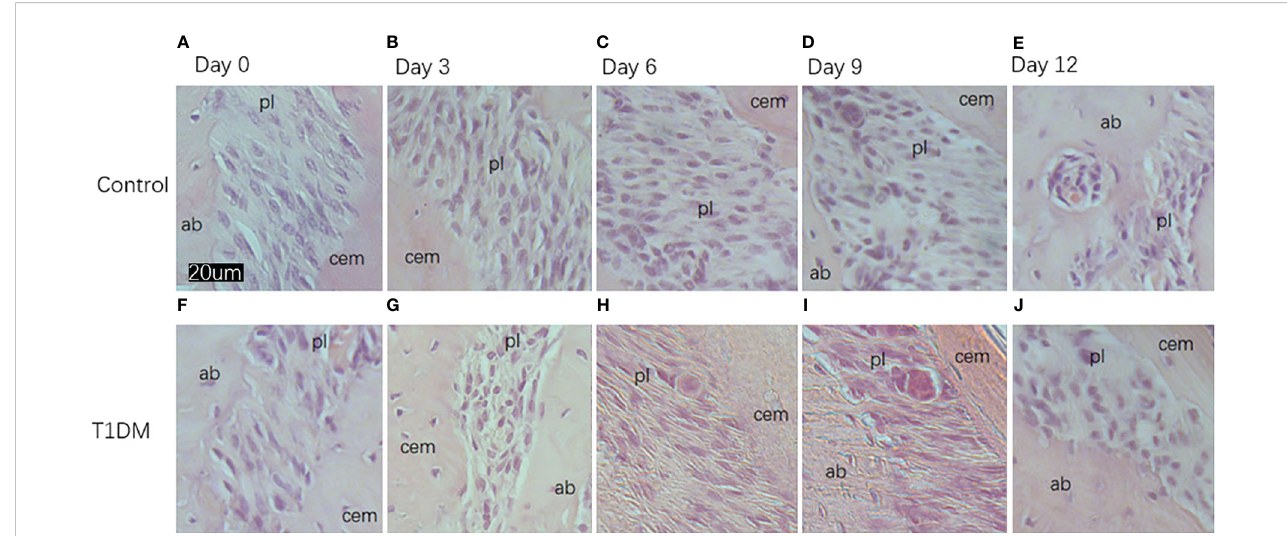
FIGURE 4 Histological appearance (HE staining)of the periodontium of mandibular molars in both groups on days 0, 3, 6, 9, and 12 of the experiment. (A – E) are from control mice, and (F – J) are from T1DM mice.3 to 12 days after the extraction of the surgery, the periodontal ligament of the corresponding mandibular molar showed irregular arrangement of cells. The cells in the periodontal ligament space, cementum, and alveolar bone surface gradually increased, and osteoclasts and osteoblasts could be observed in both groups of mice. In contrast, diabetic mice had fewer cellular components and a greater proportion of osteoclasts. cem, cementum; ab, alveolar bone; pl, periodontal ligament (×200).